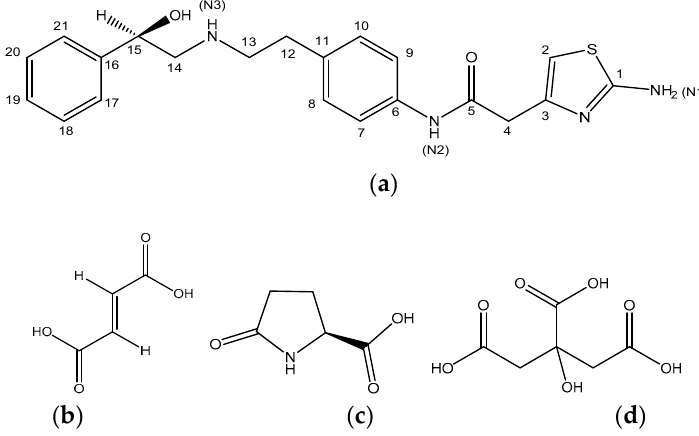
Figure 1. Chemical structures and carbon numbering for: ( a ) Mirabegron; ( b ) fumaric acid (FA); ( c ) L -Pyroglutamic acid (PG); ( d ) citric acid (CA).